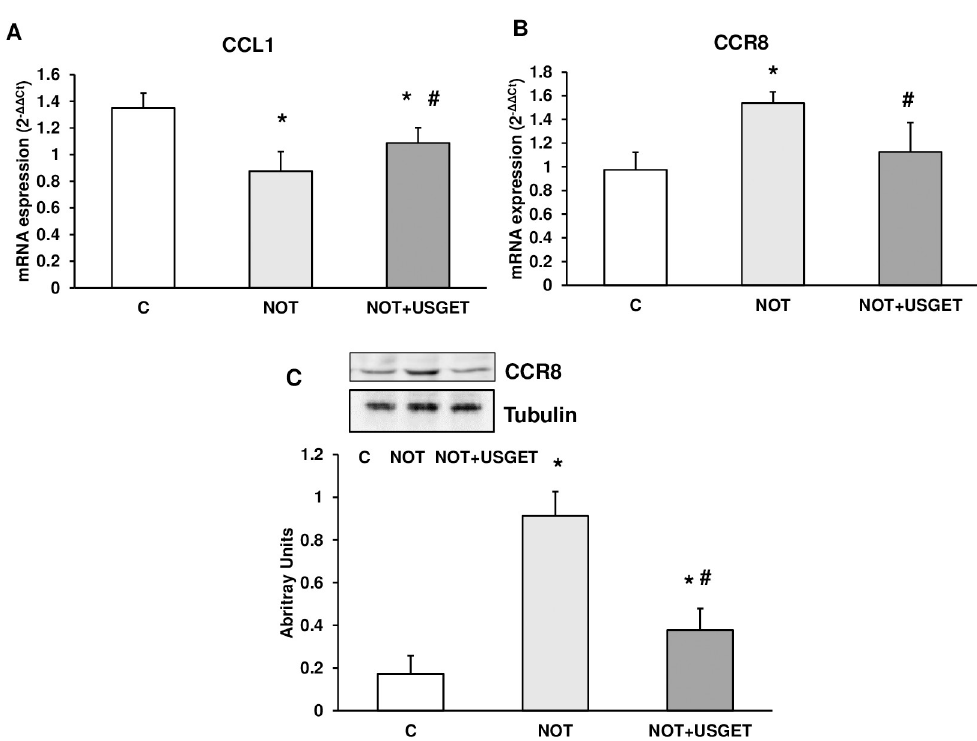
Fig 5. Rat muscle without notexin (C) or with notexin (NOT) or notexin with USGTE (6 mA) (NOT+USGTE) was collected to determine A: CCL1 and B: CCR8 by mRNA expression, and C: CCR8 by Western-blot. CCR8 and Tubulin cropped from different parts of the different gels. Data are means ± SD from five independent experiments. � p < 0.04 vs. control. #p < 0.04 vs. notexin.